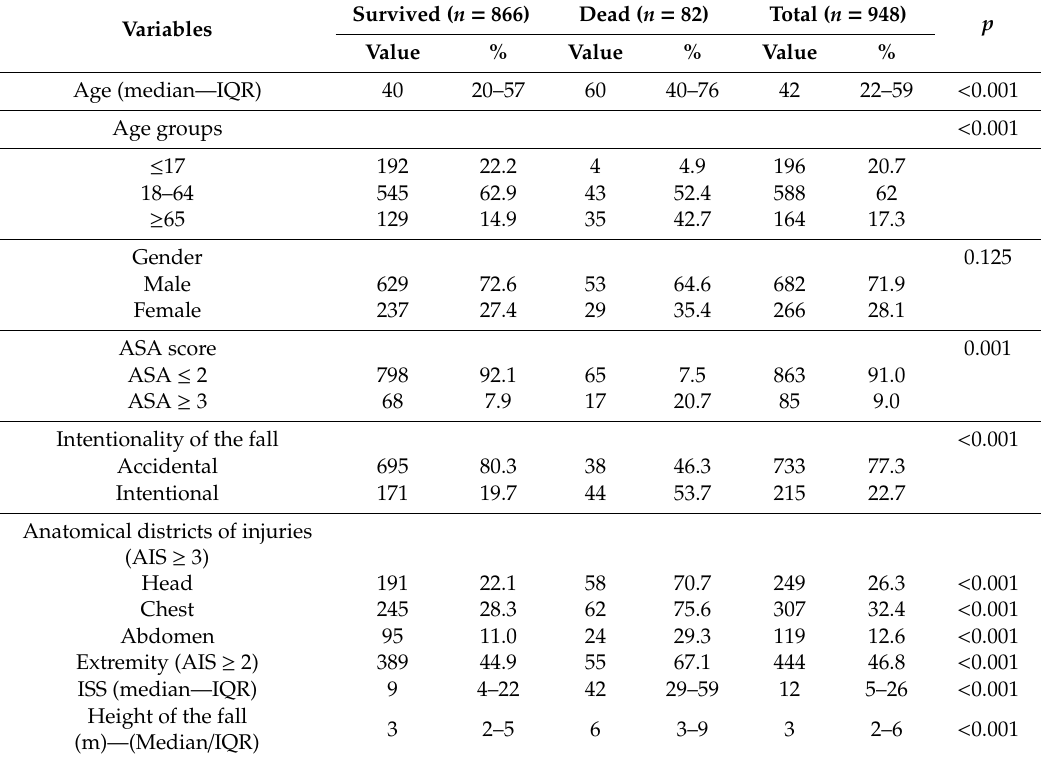
Table 2. Comparisons between survivors and